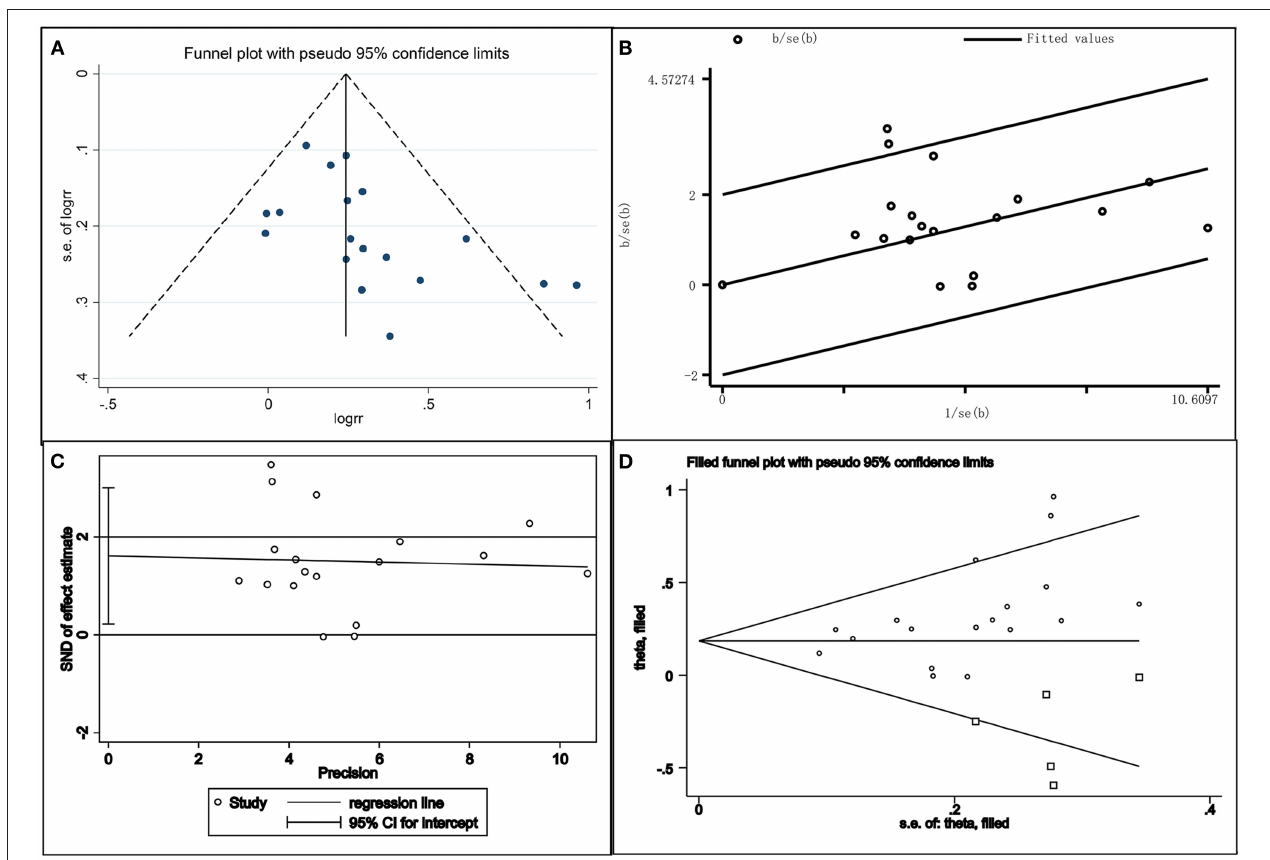
FIGURE 5 | Combination chart of the publication bias test. (A) funnel plot; (B) radial plot; (C) Egger test plot; (D) filled funnel plot.